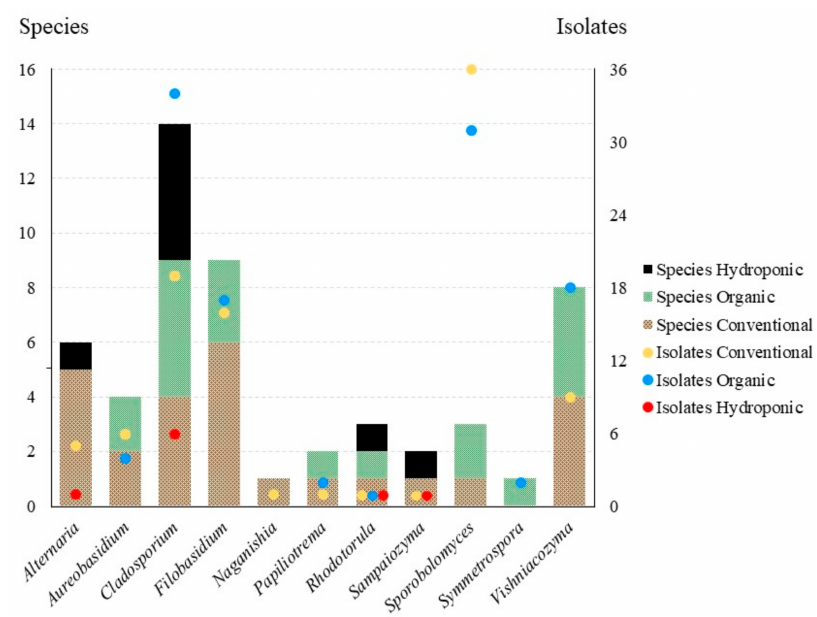
Figure 3. Number of species (bars) and isolates (circles) by treatment (conventional, organic, hydro- ponic) for “core” community